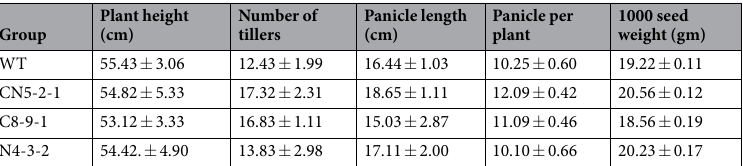
Table 1. Agronomical data evaluation of transgenic lines. All the essential parameters were measured for the transgenic plants with their wild type (WT) counterpart, grown in same condition in green house. The values represent the mean of progeny (T 3 ) 10 plants from each line ±